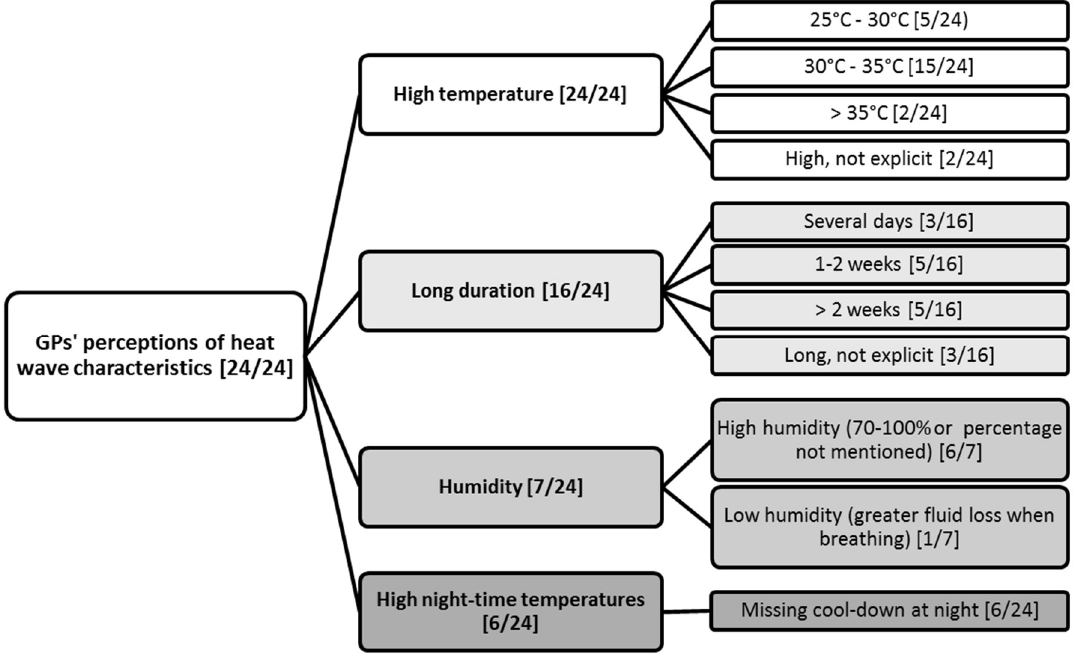
Figure A1. GPs’ perceptions of heat wave characteristics. Table A2. GPs’ perceptions of risk factors for their elderly patients to suffer from heat health impacts.